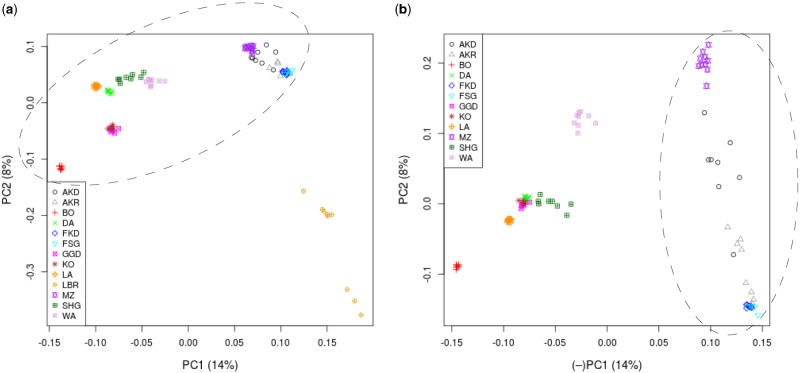
PC1 versus PC2 for PCA of genomic data: (a) Ethiopian (ringed) and Libyan (LBR) sheep populations. (b) Only Ethiopian populations (most eastern populations, used for PBS analysis, are ringed).